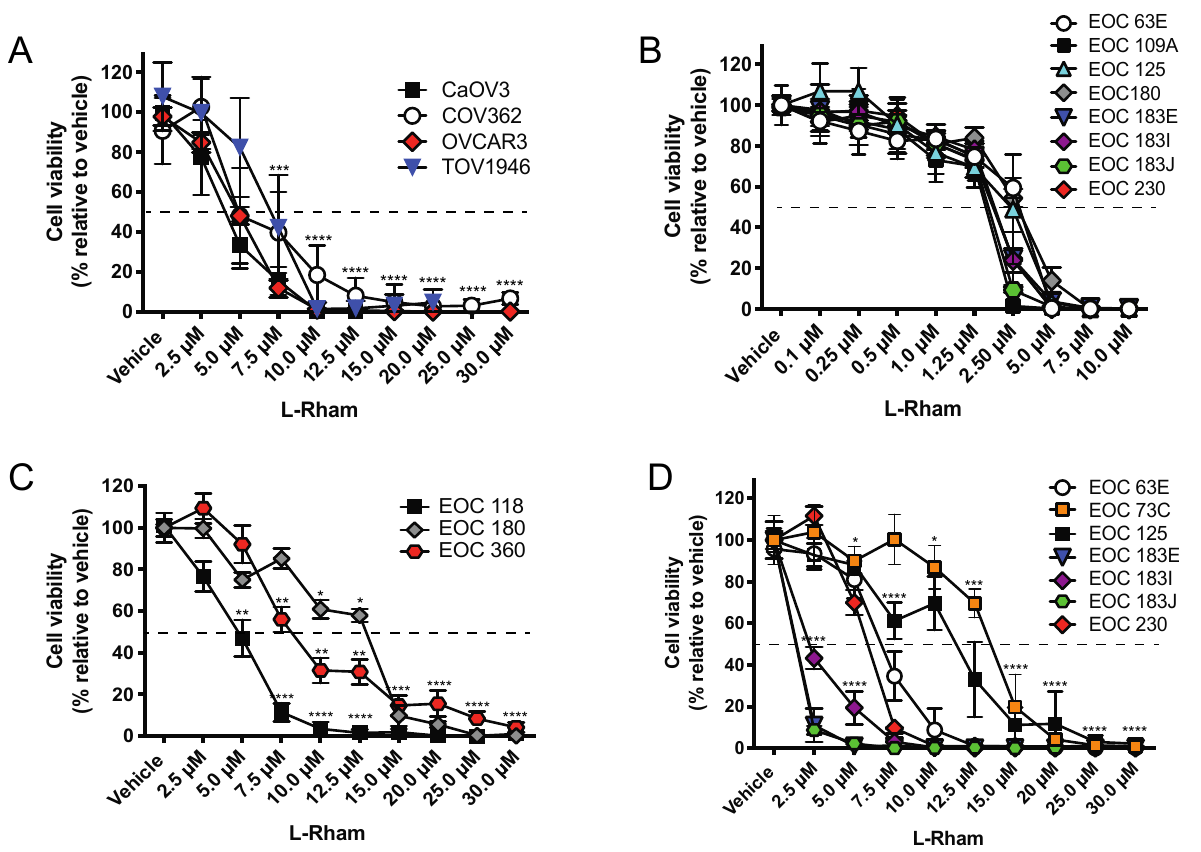
Figure 4. HGSOC cell viability after L -Rham treatment. ( A ). Dose response of established HGSOC cell lines treated with L -Rham for 48 h. Cells were grown as adherent monolayers. For ( A , B ), cells were grown as adherent monolayers, and for ( C , D ) cells, they were grown as non-adherent cell aggregates or spheres (depending on the individual sample). The dashed lines indicate 50% cell viability. Asterisks (*) indicate significant differences from vehicle-treated cells [* < 0.05, ** < 0.01, *** < 0.001, **** < 0.0001]; 2-way ANOVA with multiple comparisons was used to assess significance. ( B ). Dose response of chemosensitive and chemoresistant HGSOC patient samples treated with L -Rham for 48 h. ( C ). Dose response of chemosensitive HGSOC patient samples treated with L -Rham for 48 h. ( D ). Dose response of chemoresistant HGSOC patient samples treated with L -Rham for 48 h. Modified from reference [49], with permission.